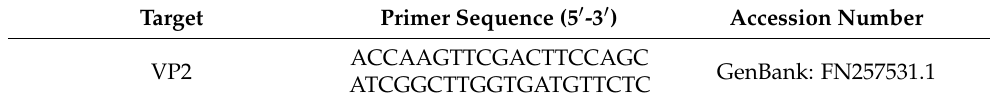
Table 1. PCR primers sequences used in gene expression studies (forward and reverse